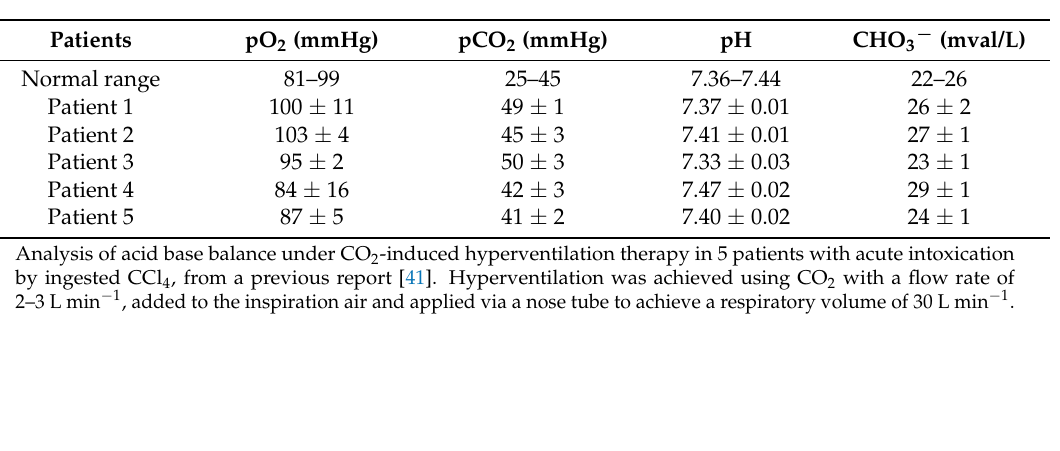
Table 6. Acid-base balance under CO 2 -induced